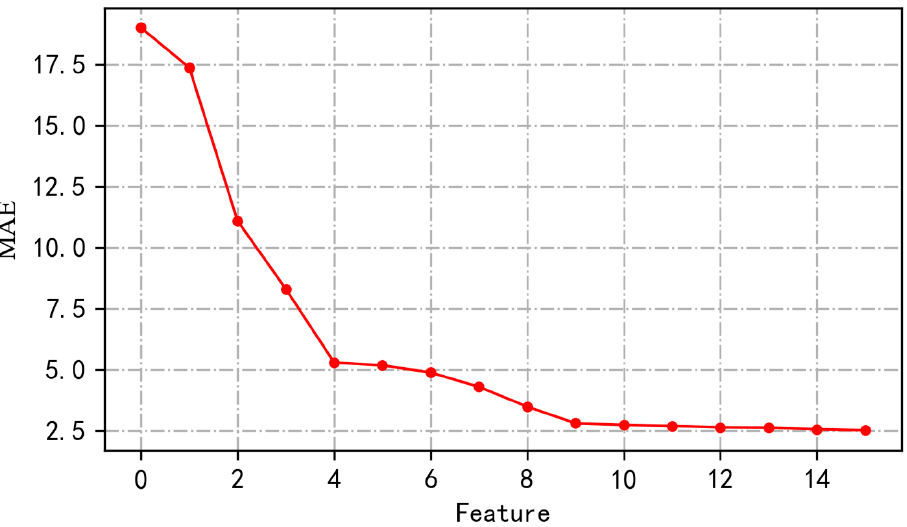
Figure 5. MAE change chart (according to IFFS, only when the MAE value drops will the MAE and the corresponding feature be